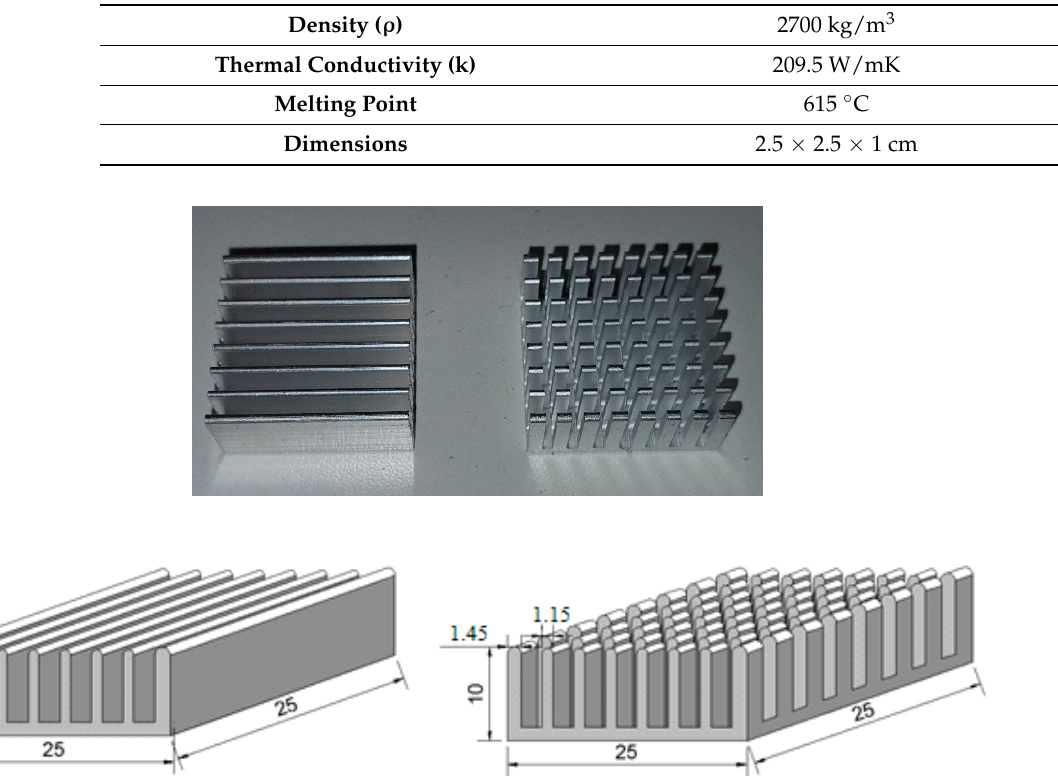
Figure 2. The schematic diagram of the plate fin and pin fin heat sinks (dimensions were given in